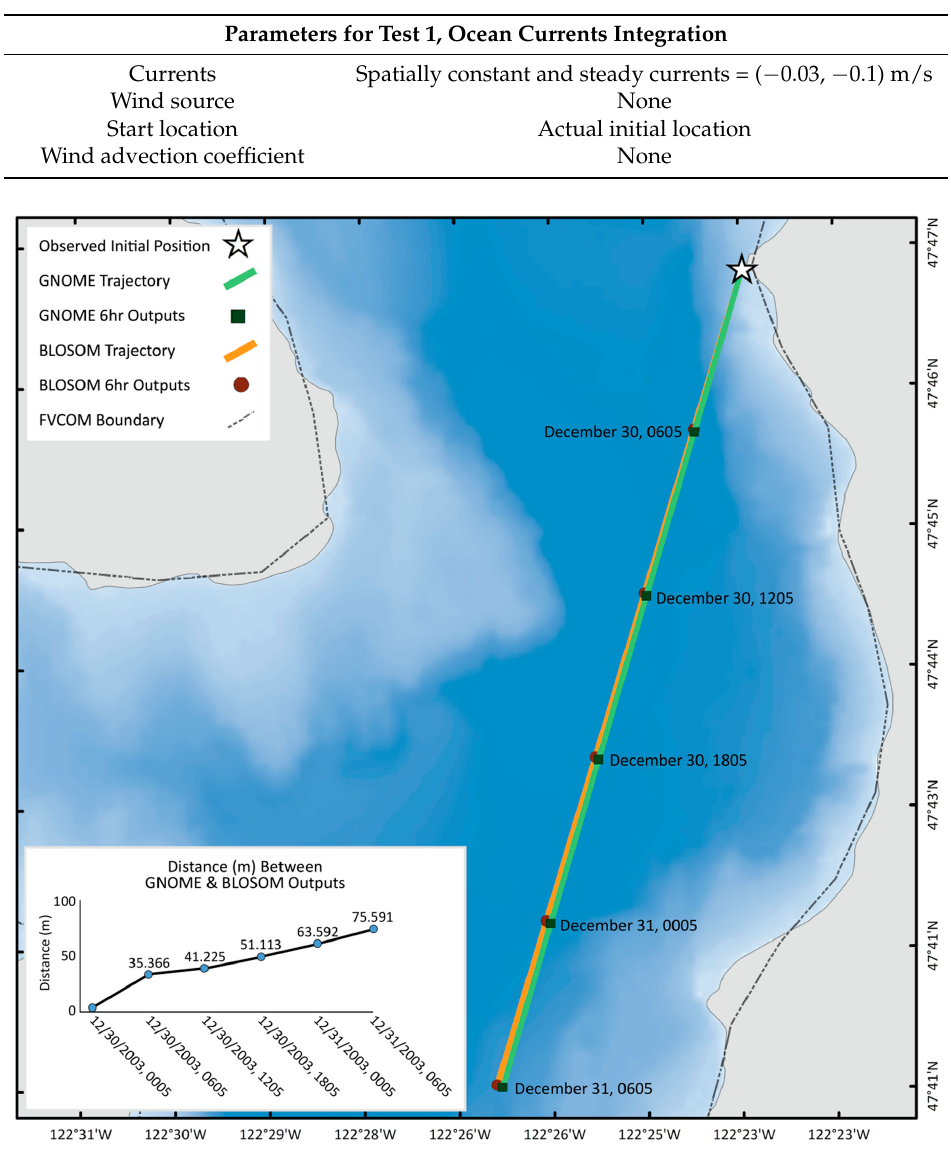
Figure 10. Comparison of advection algorithms using constant ocean currents; test 1.